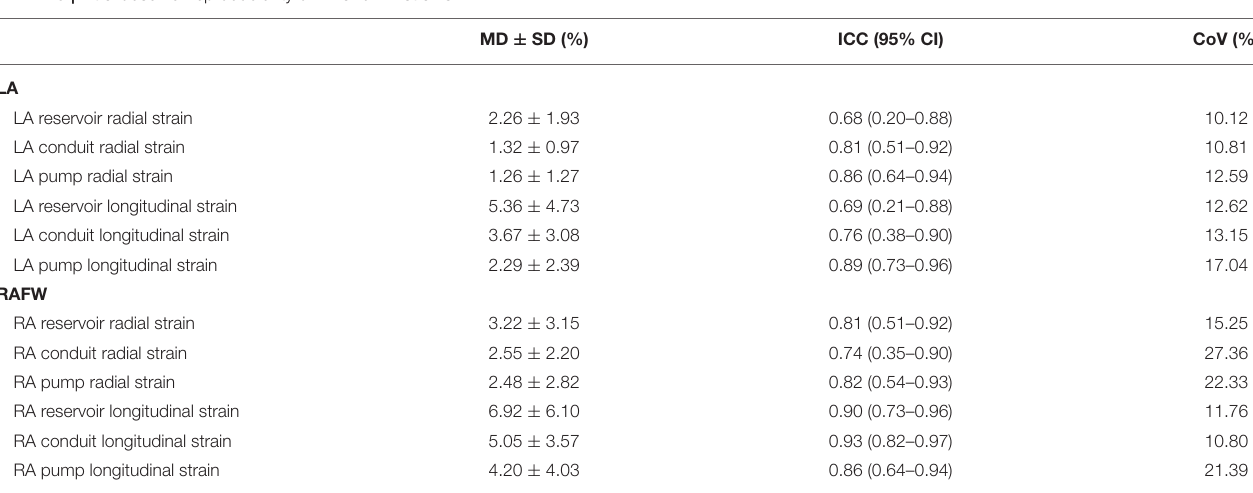
TABLE 5 | Intra-observer reproducibility of LA and RA